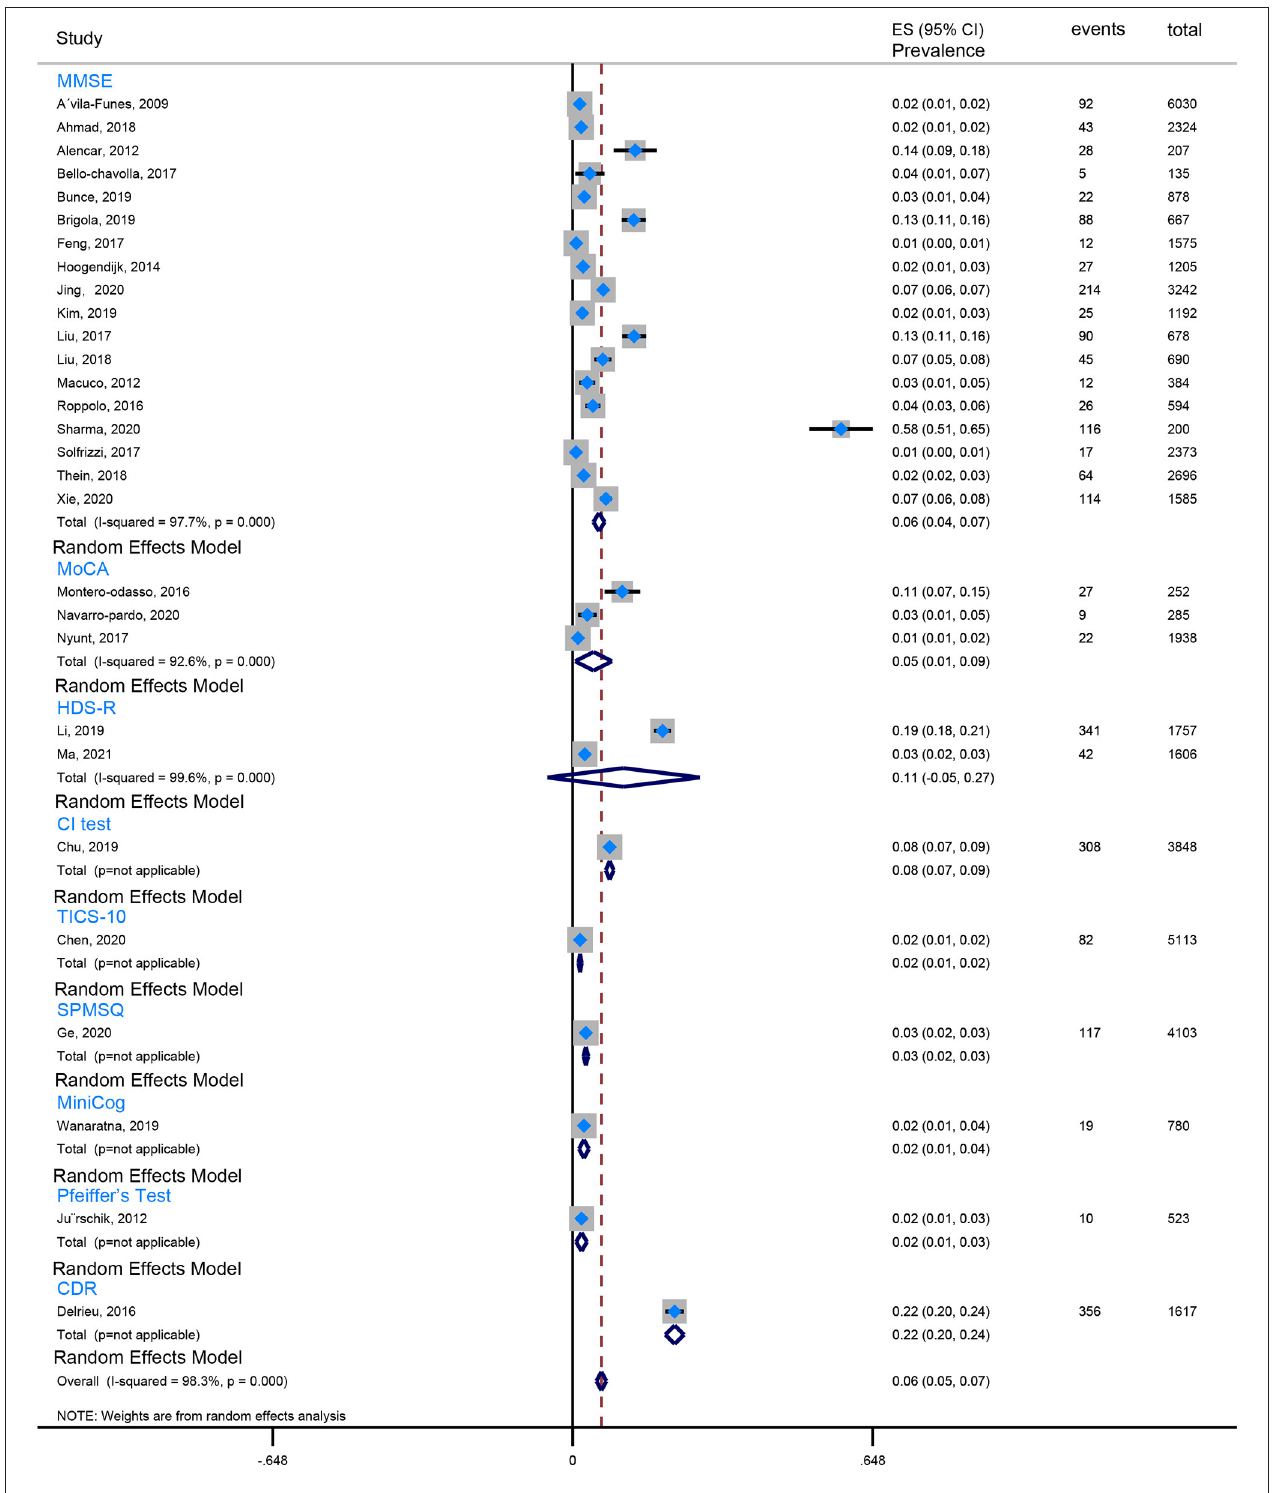
FIGURE 3 | The forest plot pooled the prevalence of CF II.